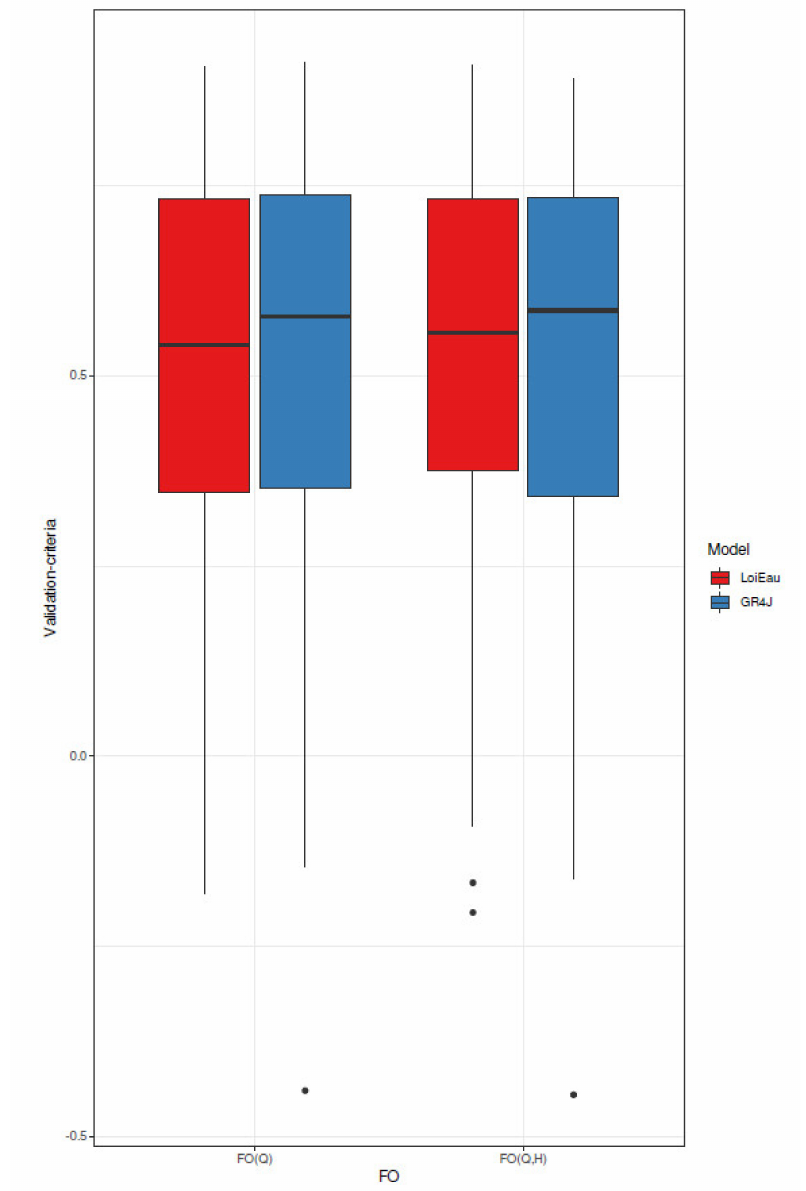
Figure 9. Synthetic distribution of evaluation criteria for objective functions FO (Q) and FO (Q, H) for each